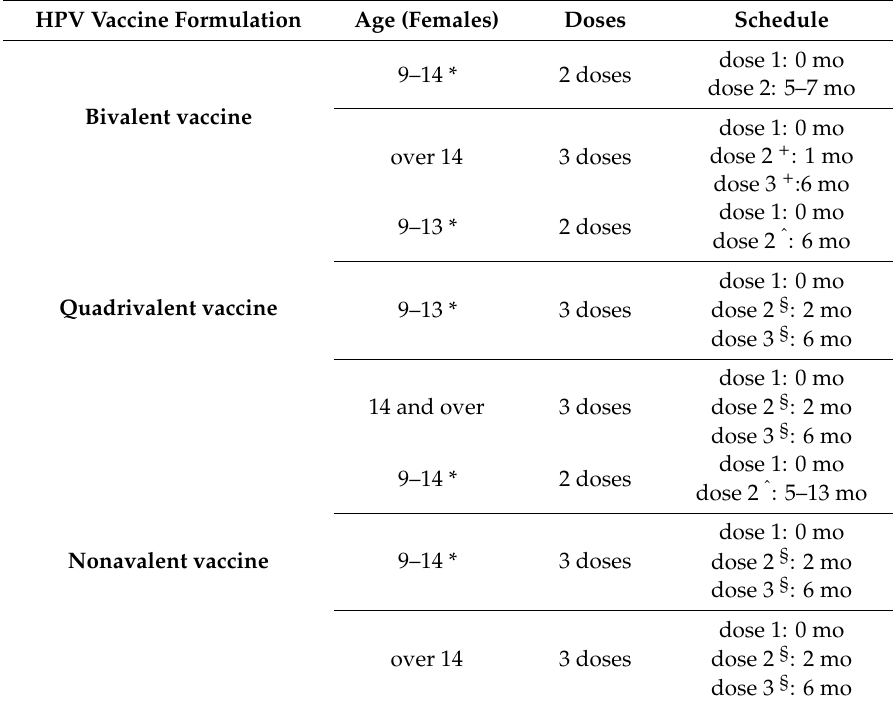
Table 1. Italian HPV vaccine